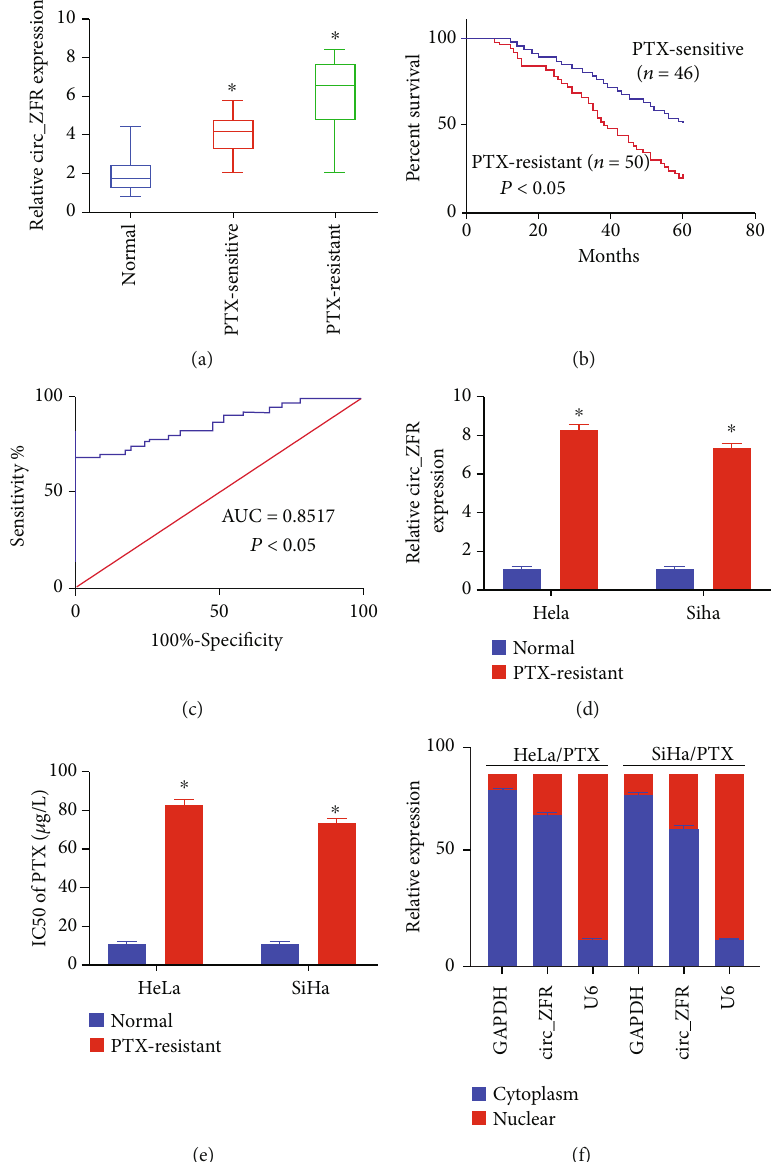
Figure 1: The overexpression of circ_ZFR in CC cells and tissues (PTX-resistant). (a) The qRT-PCR evaluations of circ_ZFR expression in CC tissues. (b) The survival rate in CC patients. (c) The ROC curve analysis of circ_ZFR for CC resistance. (d) The data of circ_ZFR expression obtained from the qRT-PCR assay. (e) The PTX IC 50 values. (f) circ_ZFR expression in the nuclear and cytoplasm with ∗ p < 0 : 05